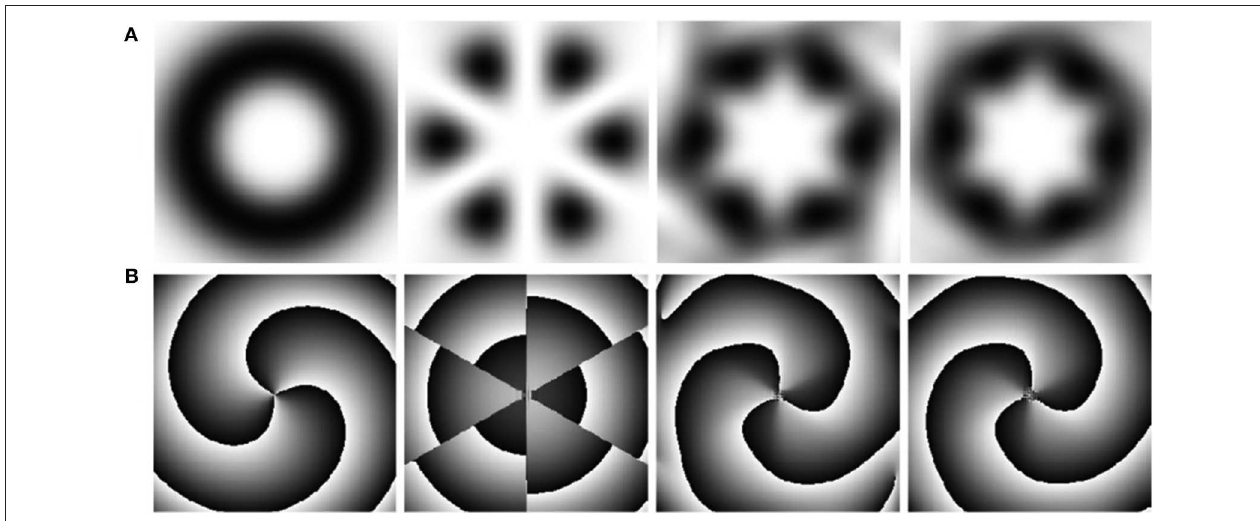
FIGURE 2 | (A) Amplitude and (B) phase distributions of the fields of the Laguerre –Gaussian and synthesized vortex beams shown in Figure 1 during the beam propagation in a free space to a distance z 0.5 k 0 a 2 =